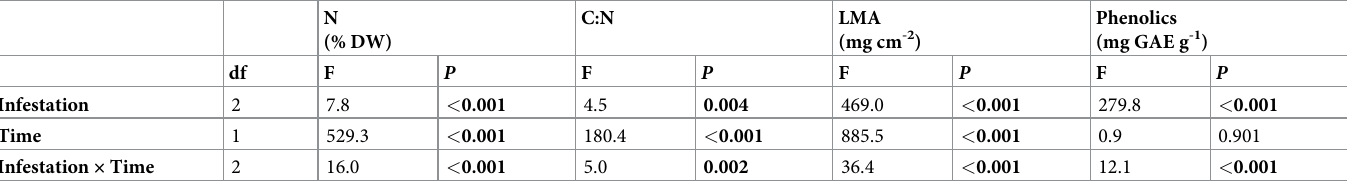
Table 1. F and P values of two-way ANOVA examining the effect of infestation status (Infestation status: Control, uninfested; vH-13-US and vH13-ISR [individual responses], compatible; GP, incompatible), time of infestation (Time: Four and twelve days post infestation), and their interaction on nitrogen (N), ratio of carbon to nitrogen (C:N), leaf mass per area, and